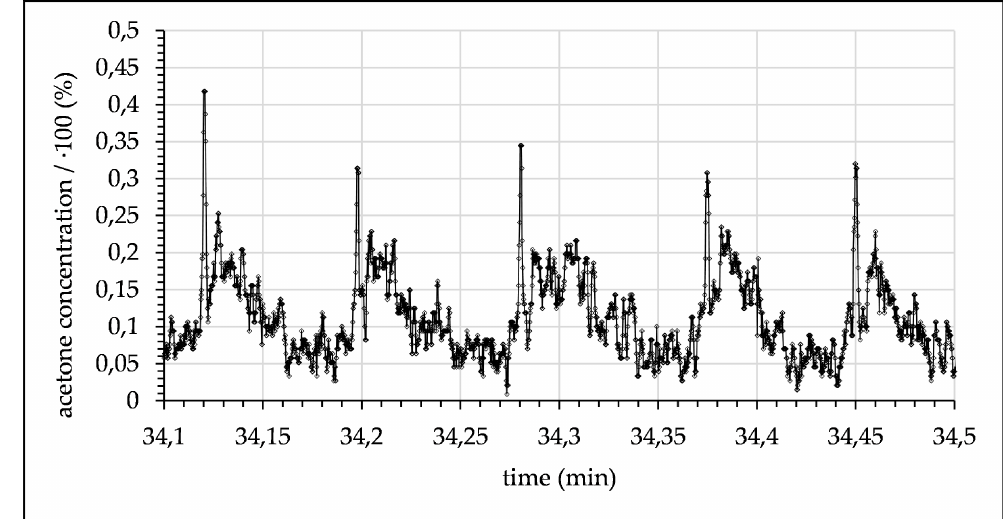
Figure 11. Measured acetone concentration in toluene droplets alternating with water phase (0.02 mL/min with a 7.5 s time delay after contact of toluene and water).